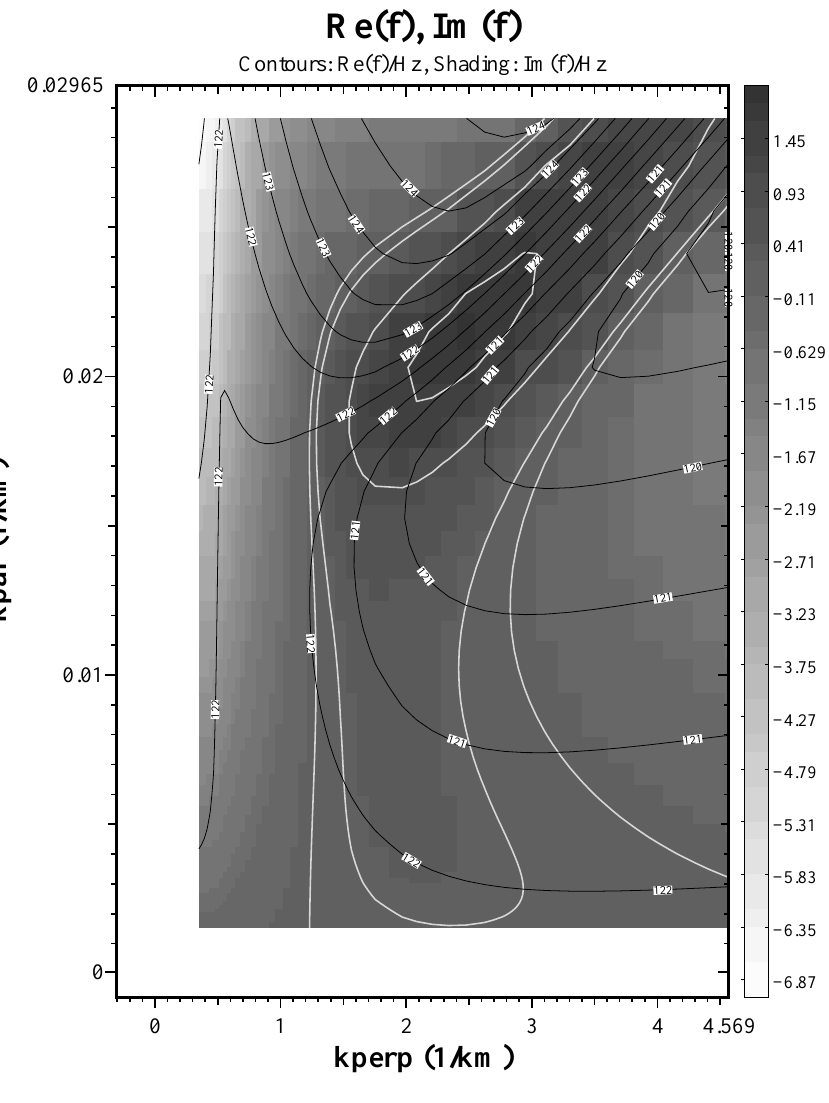
Fig. 6. Frequency (black labelled con- tours) and temporal growth rate (shad- ing) for seventh Bernstein mode. White contours are drawn at 0%, 10%, 50%, and 90% of the maximum growth rate. The wave vector k = 2 π/λ is in units of km − 1 . Here, k = 0 . 1 km − 1 corre- sponds to kρ i = 1, where ρ i = 10 km is the Larmor radius of the shell distri- bution (5 keV)